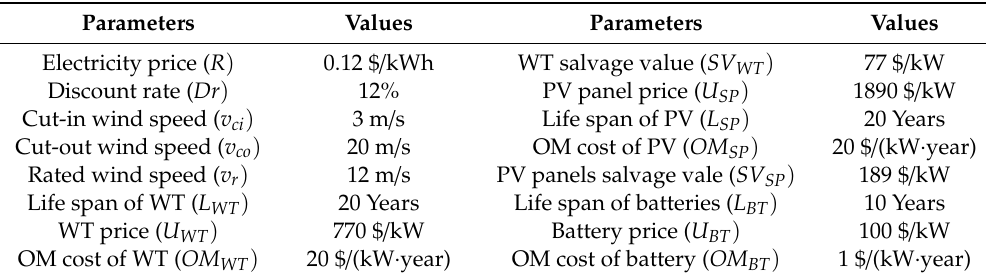
Table 1. Input parameters for networked microgrid.